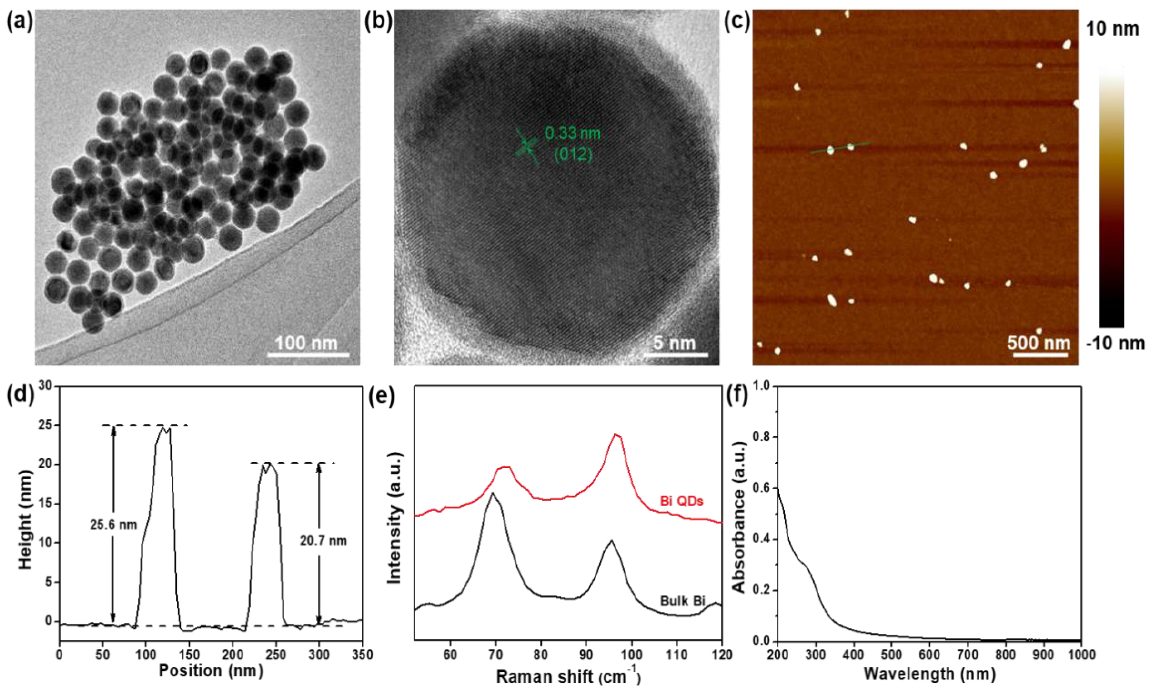
Figure 2. Structural characterization. ( a ) TEM image and ( b ) HRTEM image of the as-synthesized 0D Bi QDs, ( c ) AFM image and ( d ) the corresponding height profile of the 0D Bi QDs, ( e ) Raman spectra of bulk Bi and 0D Bi QDs, and ( f ) UV-Vis-NIR spectrum.